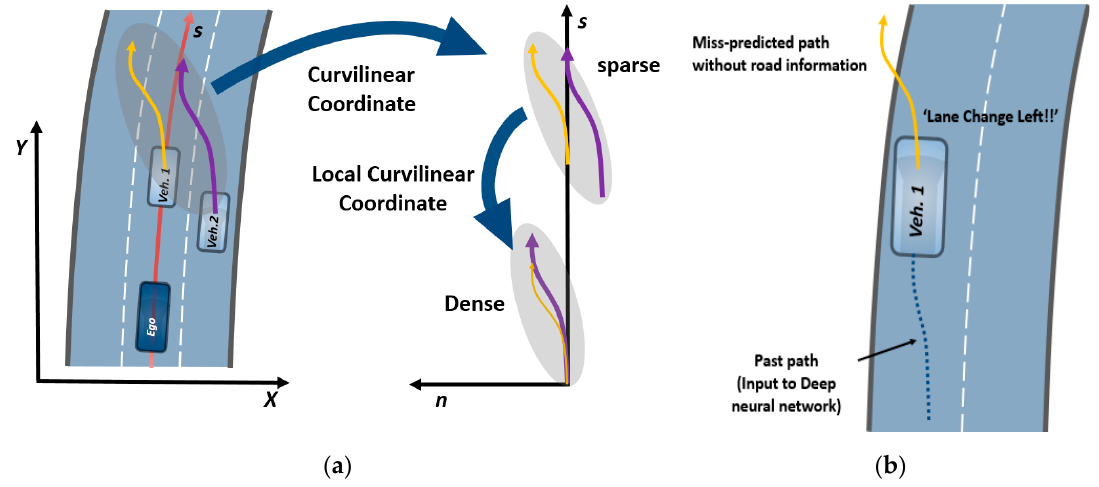
Figure 2. Practical problem statement. ( a ) If we represent trajectories of the surrounding vehicles in the local curvilinear coordinate system, the data distribution becomes compact; ( b ) Wrong prediction is caused by a zigzag motion of the vehicle without any road constraint.